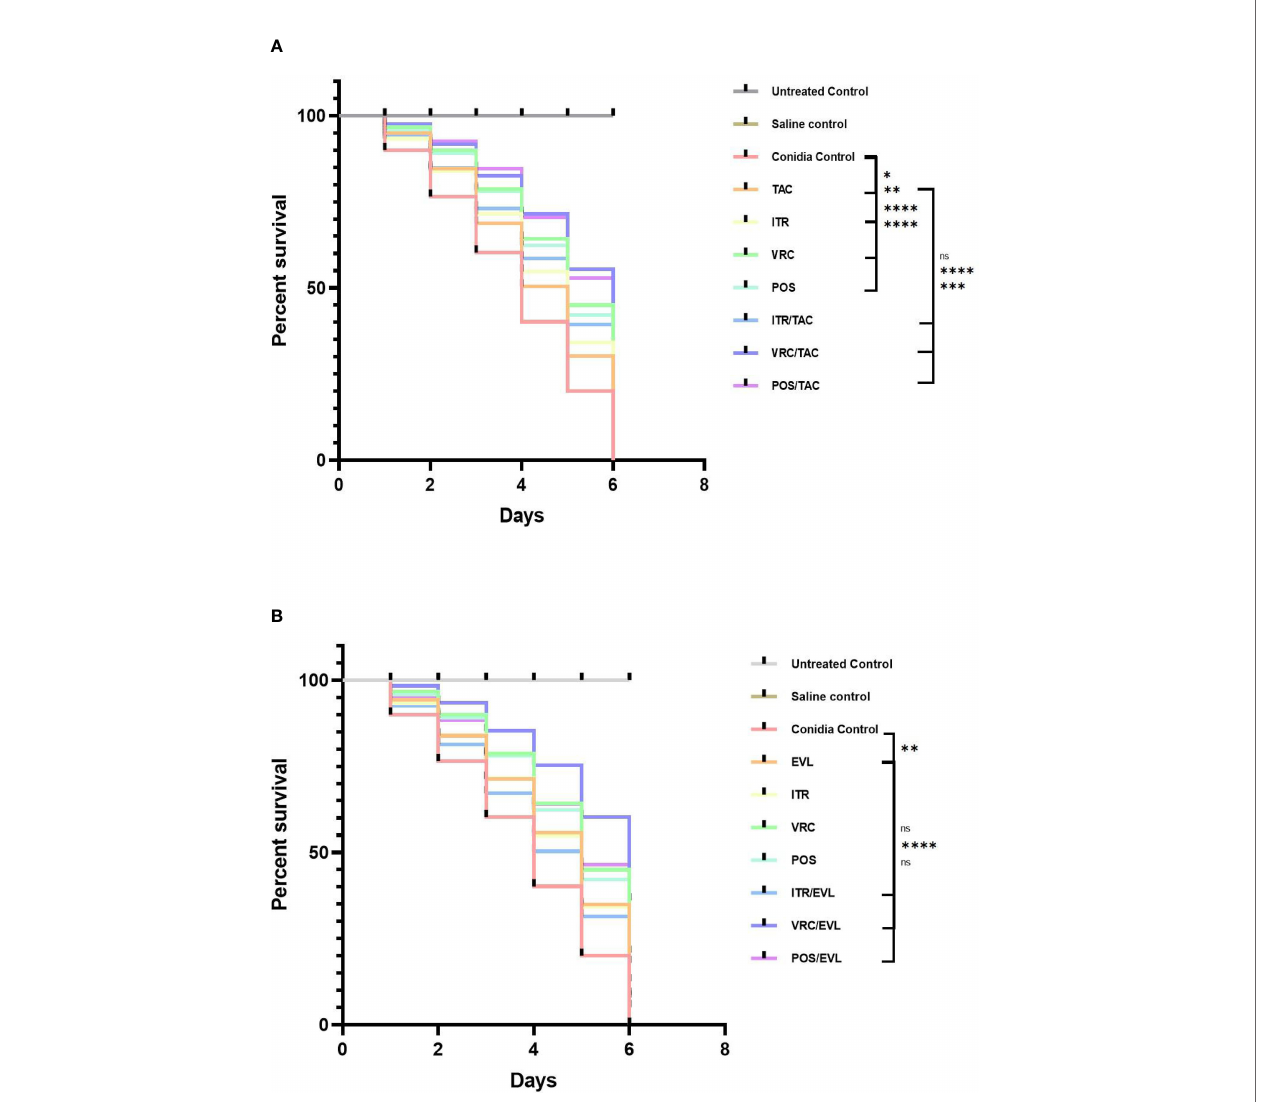
FIGURE 5 | The survival curves of larvae infected with Scedosporium after different interventions. (A) TAC group (B) EVL group. G. mellonella infected with Scedosporium . Tacrolimus, everolimus, and azoles alone or in combination with tacrolimus or everolimus can signi fi cantly improve the survival rate of larvae. Tacrolimus and everolimus combined with azoles showed a synergistic effect on Scedosporium infection. TAC, tacrolimus; EVL, everolimus; ITR, itraconazole; VRC, voriconazole; POS, posaconazole. *P < 0.05; **P < 0.01; ***P = 0.0001; ****P < 0.0001; ns, no signi fi